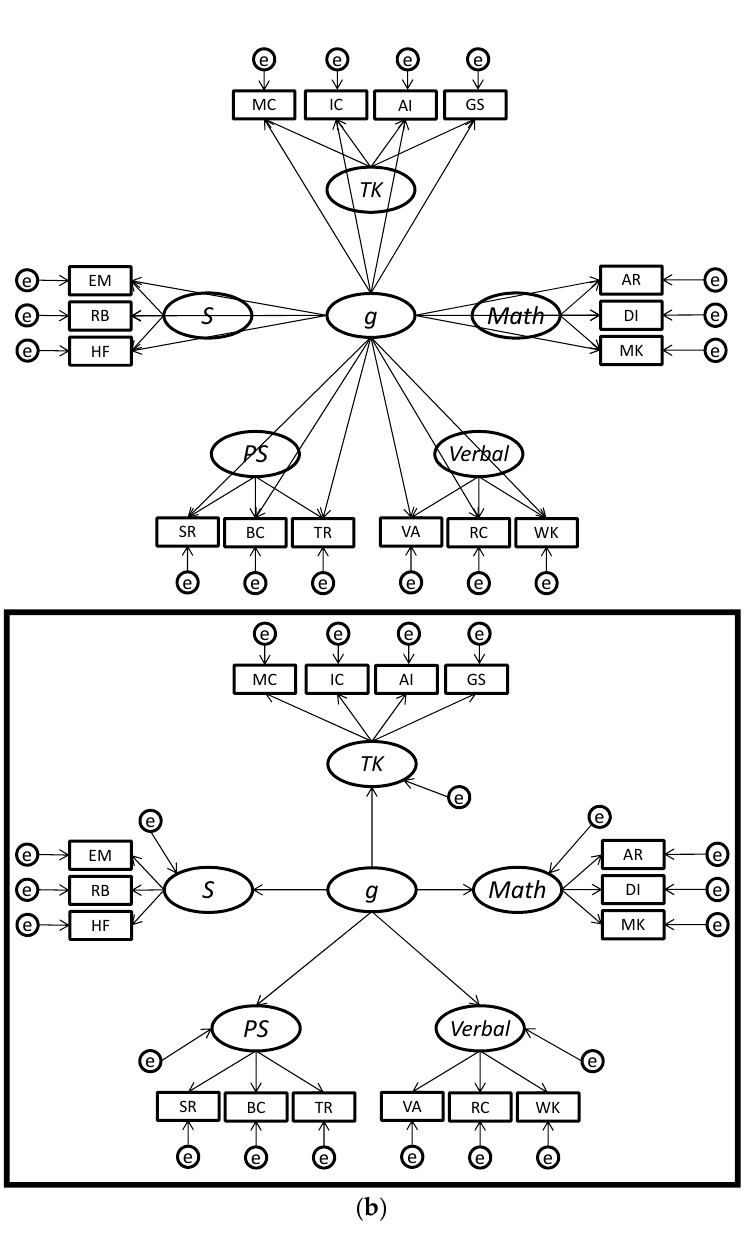
Figure 2. ( a ) This figure shows the bifactor model for the DAT-ASVAB test battery, with the corresponding higher-order model shown in the inset; ( b ) This figure shows the bifactor model for the AFQOT battery, with the corresponding higher-order model shown in the inset. For the sake of clarity, only primary loadings are depicted. The bifactor model that only included primary loadings had better fit statistics (Comparative Fit Index (CFI) = .924; Tucker-Lewis Index (TLI) = .897; Normed Fit Index (NFI) = .921; Akaike Information Criterion (AIC) = 2,333) than the higher-order model (CFI = .900; TLI = .879; NFI = .897; AIC = 3000), and the Δχ 2 of 690 ( df = 11, p < .001) was significant.